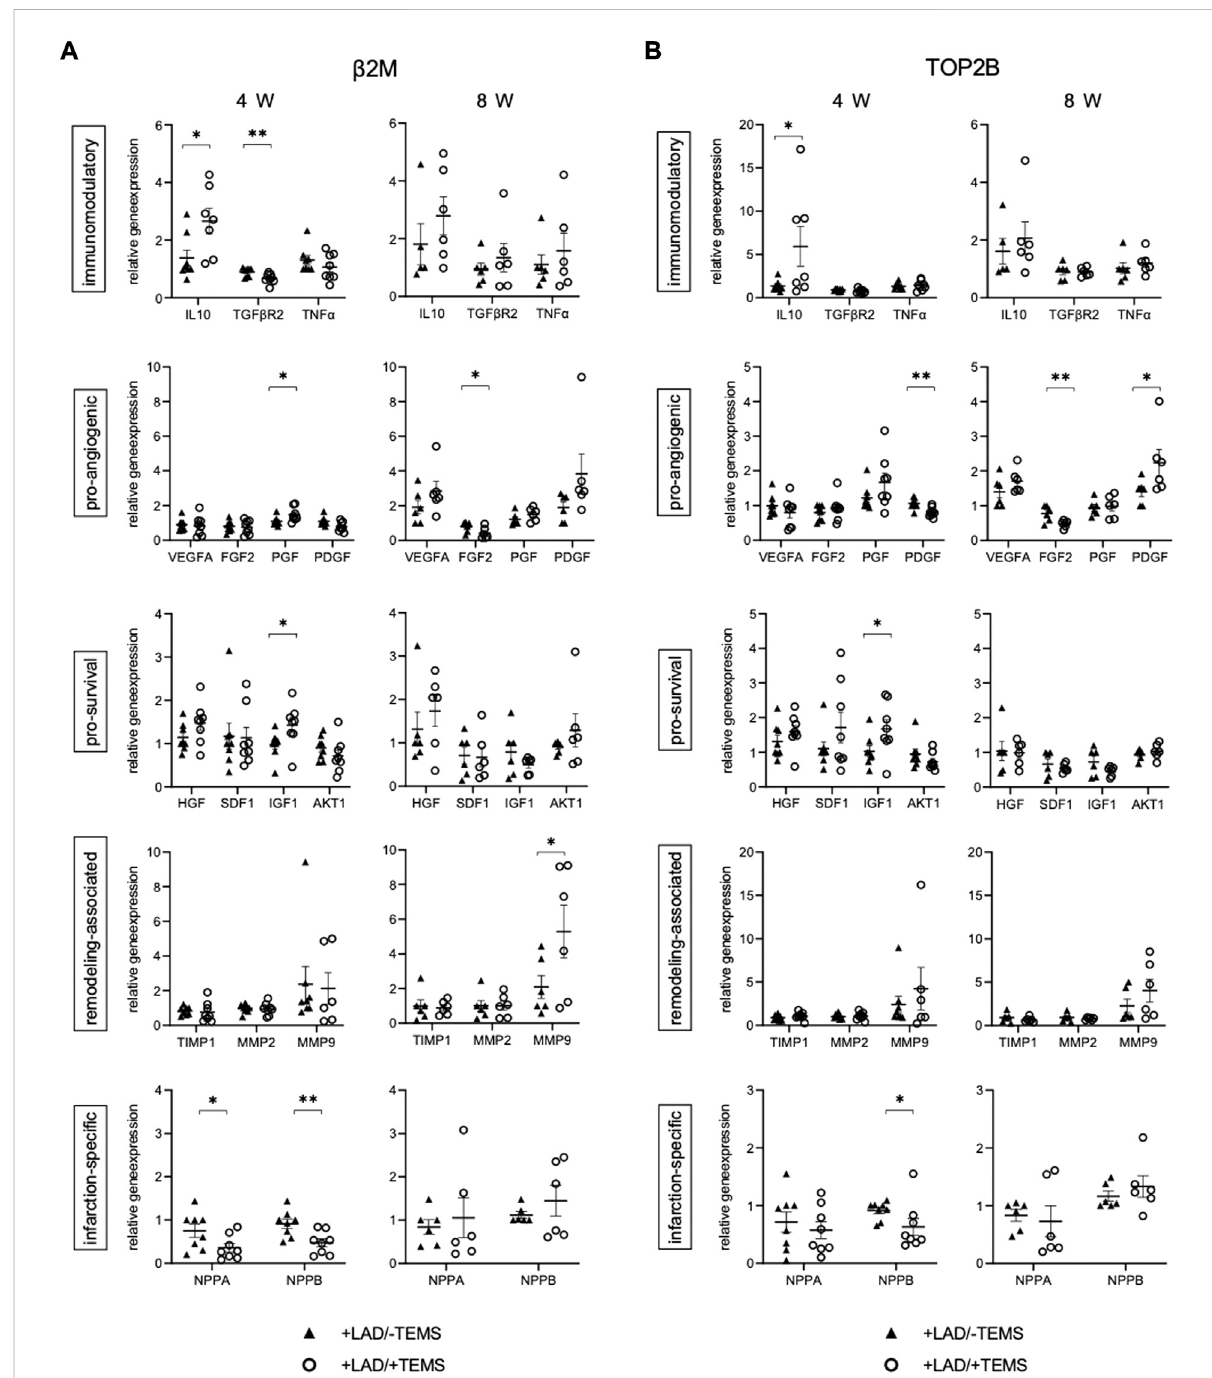
FIGURE 5 Gene expression after myocardial infarction with and without ventricular stabilization via TEMS implantation. Relative gene expression patterns of left anterior wall myocardial tissue samples after myocardial infarction via LAD-ligation (+LAD) and either 4 or 8 weeks of ventricular stabilization via TEMS implantation (+TEMS) or respective sham control (-TEMS). (A) Gene expression relative to β 2M housekeeping gene. (B) Gene expression relative to TOP2B housekeeping gene. Data presented as mean ± SD; *, p < 0.05; **, p < 0.01; ***, p <